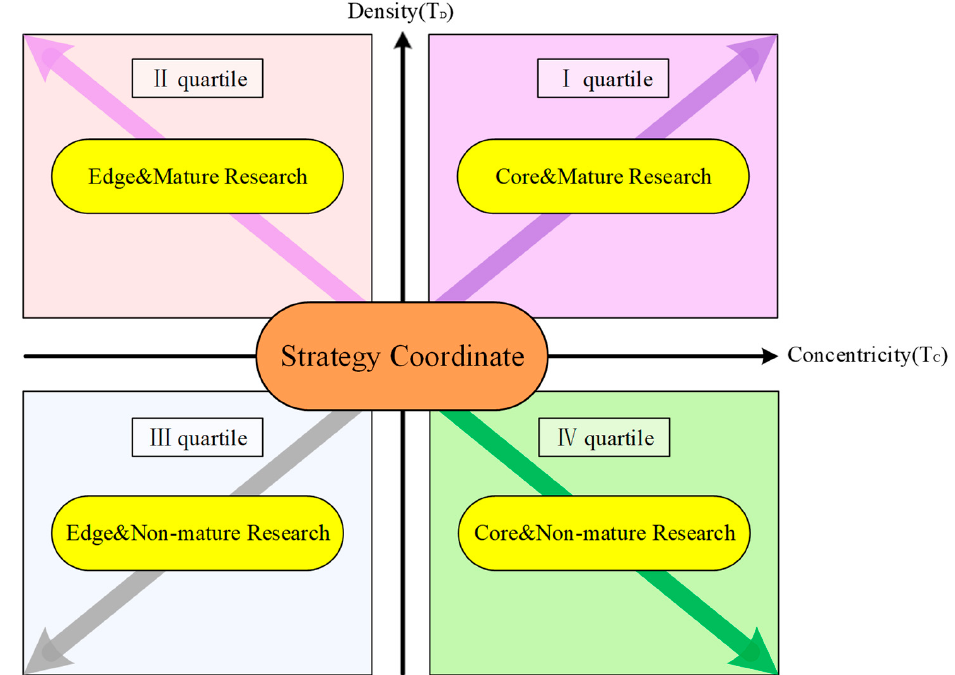
Figure 11. Principle of Strategic